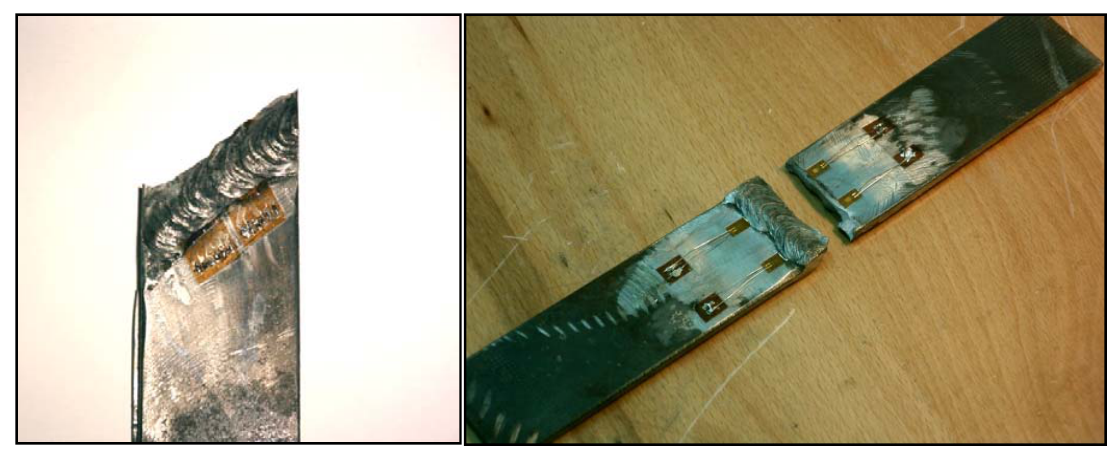
Figura 1: Alcuni esempi dei giunti saldati in acciaio utilizzati per i test di